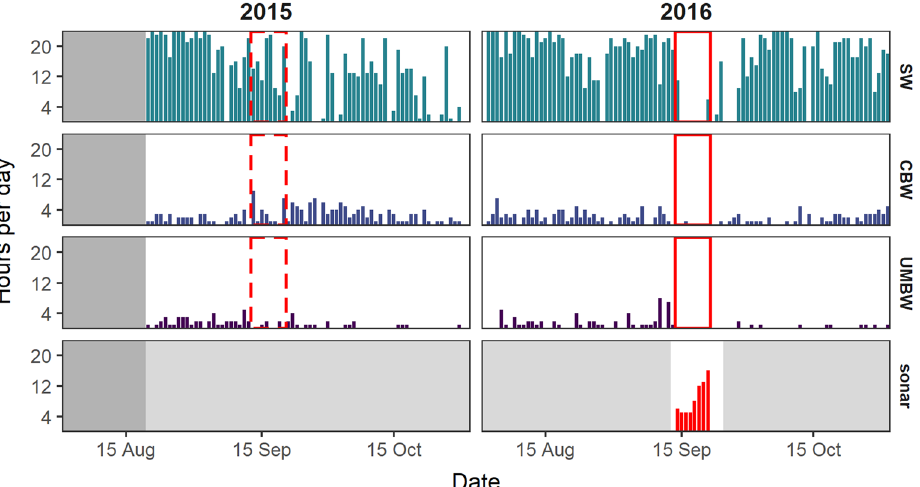
Figure 2. Number of hours per day with echolocation clicks from sperm whales (SW), Cuvier’s beaked whales (CBW), unidentified Mesoplodont beaked whales (UMBW), and sonar signals at the Station 5 recording site in 2015 and 2016. Dark grey shading in August 2015 indicates the period with no data available; light grey shading on the sonar plot indicates periods not analyzed for the presence of sonar signals. The solid red box delineates the period with sonar detections in 2016; the dashed box delineates the corresponding control period in